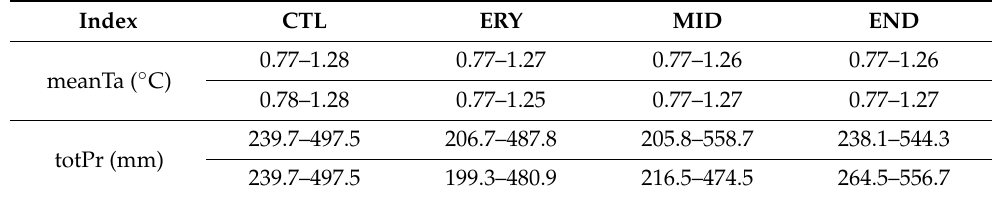
Table 5. The minimum and maximum of the USTO values over 40 locations, which are computed for the whole year for the control (CTL) and 3 future periods (ERY, MID, and END) of scenario RCP 8.5 (the first row of each index) for CMIP5 and scenario SSP5-8.5 (the second row of each index) for